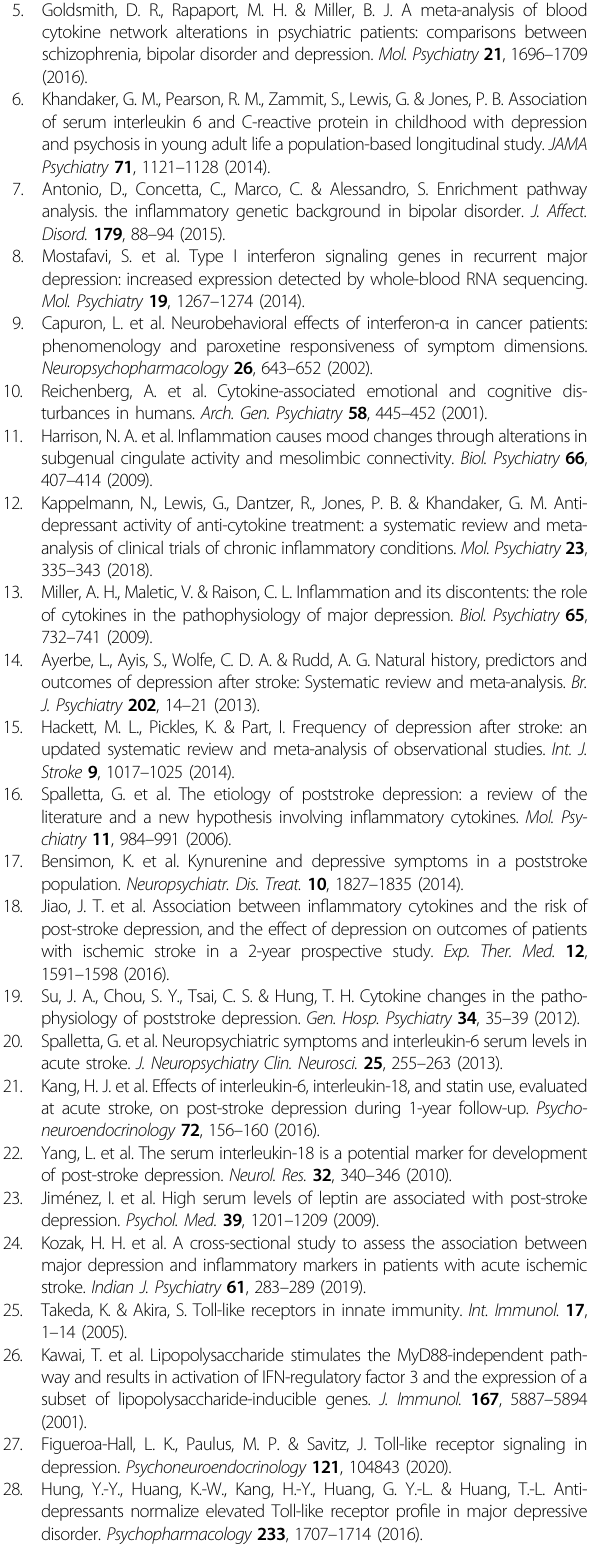
Table 4 Associations of cytokines with severity of depressive